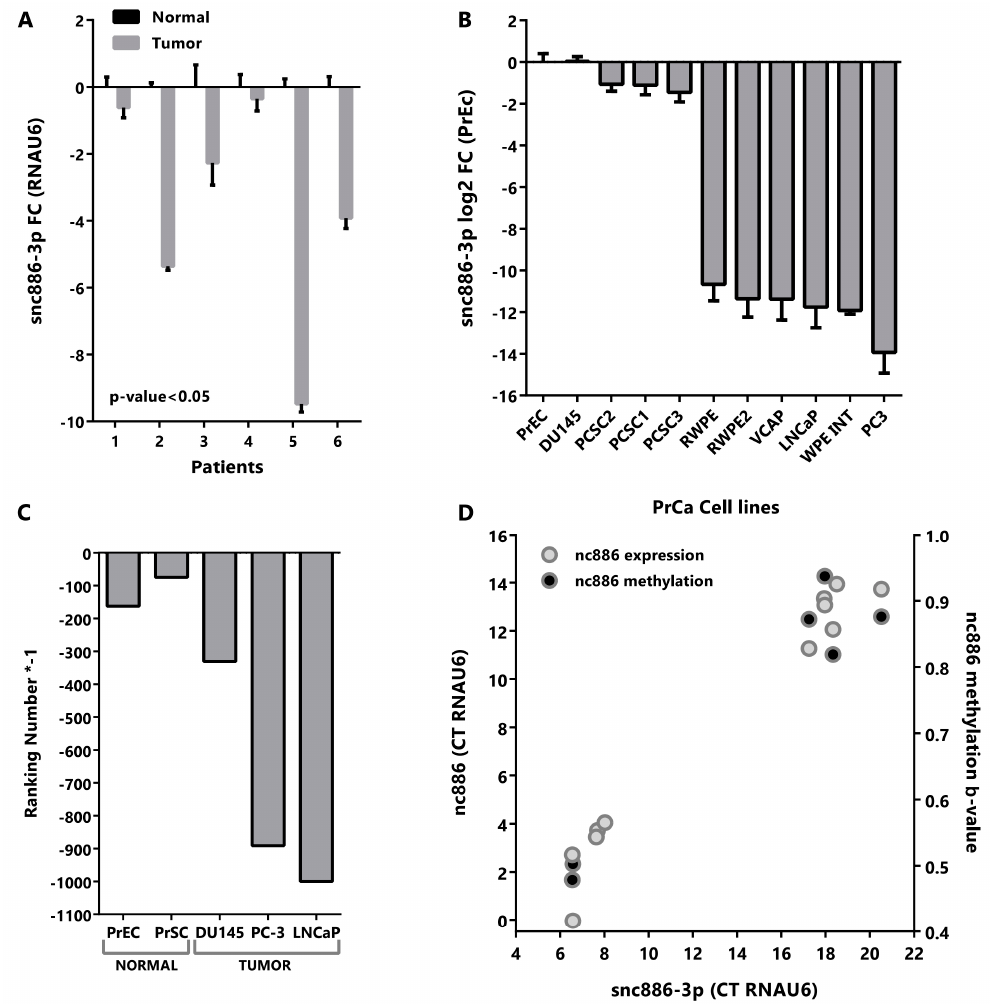
Figure 2. Snc886-3p is downregulated in tumor vs normal prostate tissue and cell lines. ( A ) Expression of snc886-3p in paired normal and tumor tissues from patient prostatectomies. Expression of snc886-3p in tumor relative to normal matched prostate tissue was determined by qRT-PCR ( ΔΔ Ct) using RNAU6 as normalizer. Two-tailed paired T-test was performed. ( B ) Expression of snc886-3p in prostate cell lines. Expression of snc886-3p relative to normal prostate cell line PrEc, determined by qRT-PCR ( ΔΔ Ct) using RNAU6 as normalizer. The order of the cell lines is only based on the expression of snc886-3p ( C ) Expression of snc886-3p in transcriptomic analysis of small non-coding RNAs from different prostate normal (GEO id: GSE26970) and tumor (SRA id: SRP109305 and GEO id: GSE66035) cell lines. For a better comparison of the different cell lines considering the differences in the depth sequencing among experiments, ranking number of appearances of snc886-3p is shown. ( D ) Correlation between nc886 and snc886-3p expression and average TSS200nt methylation on prostate cell lines (GSE68379: PrEc, RWPE-1, DU145, PC3, VCAP and LNCaP). Expression data is the same as in ( B ). Average values and standard deviation are shown.